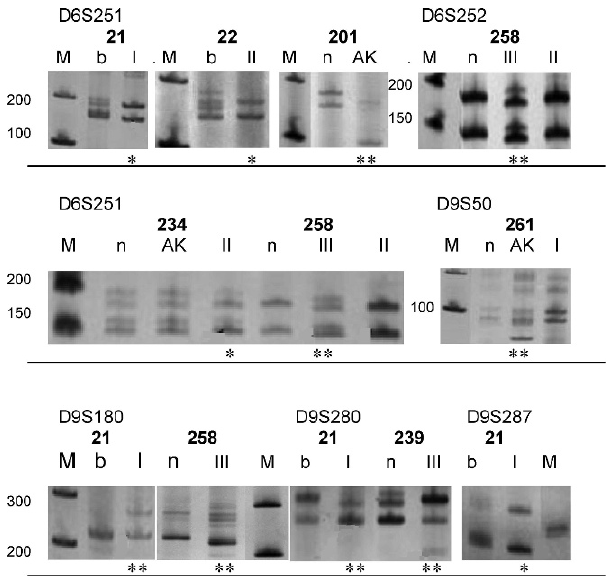
Figure 1 - The D6S251, D6S252, D9S50, D9S180, D9S280, and D9S287 microsatellites were visualized on a silver nitrate-stained polyacrylamide gel. Patient identification (bold numbers). Leucocytes (b), normal tissue (n), actinic keratosis (AK), and squamous cell carcinoma (SCC) grades I, II, and III. (*) LOH, (**) MSI, (M) Molecular marker (bp).